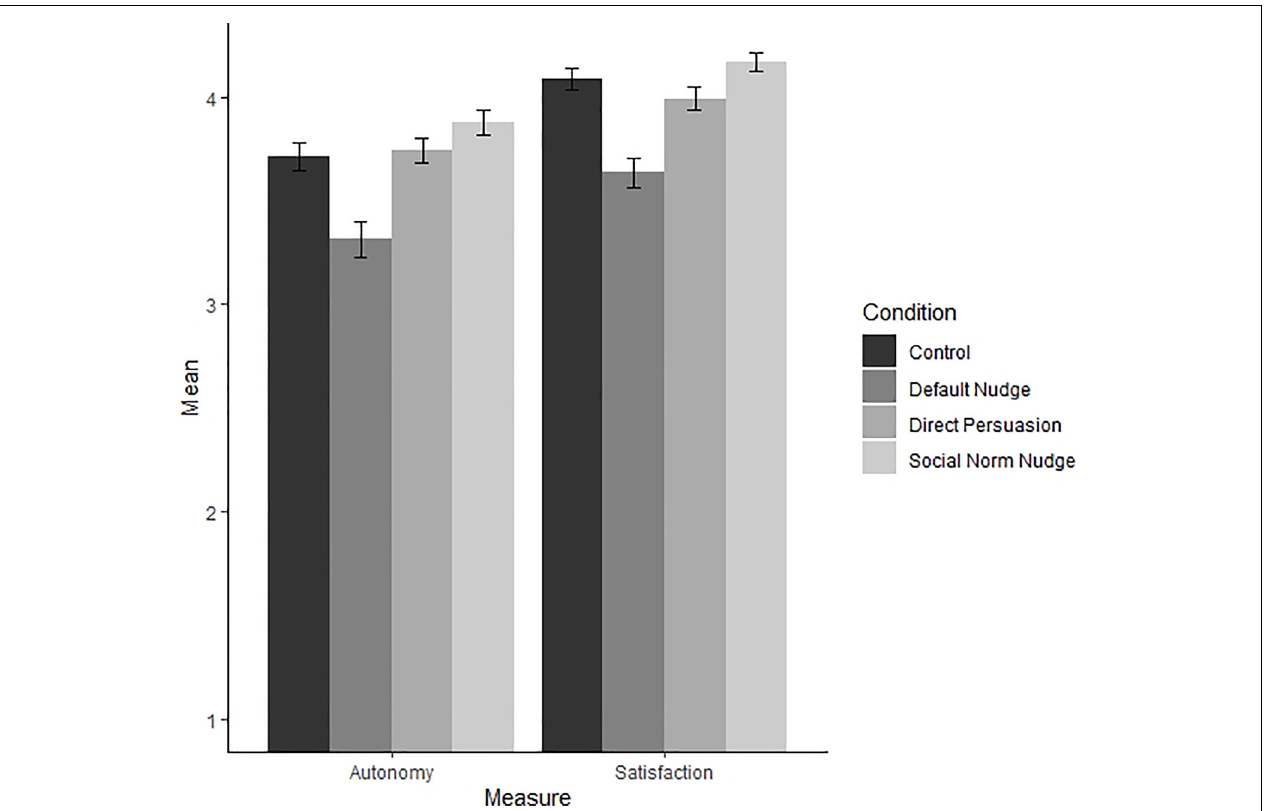
FIGURE 2 | Autonomy, competence, and satisfaction per condition (Study